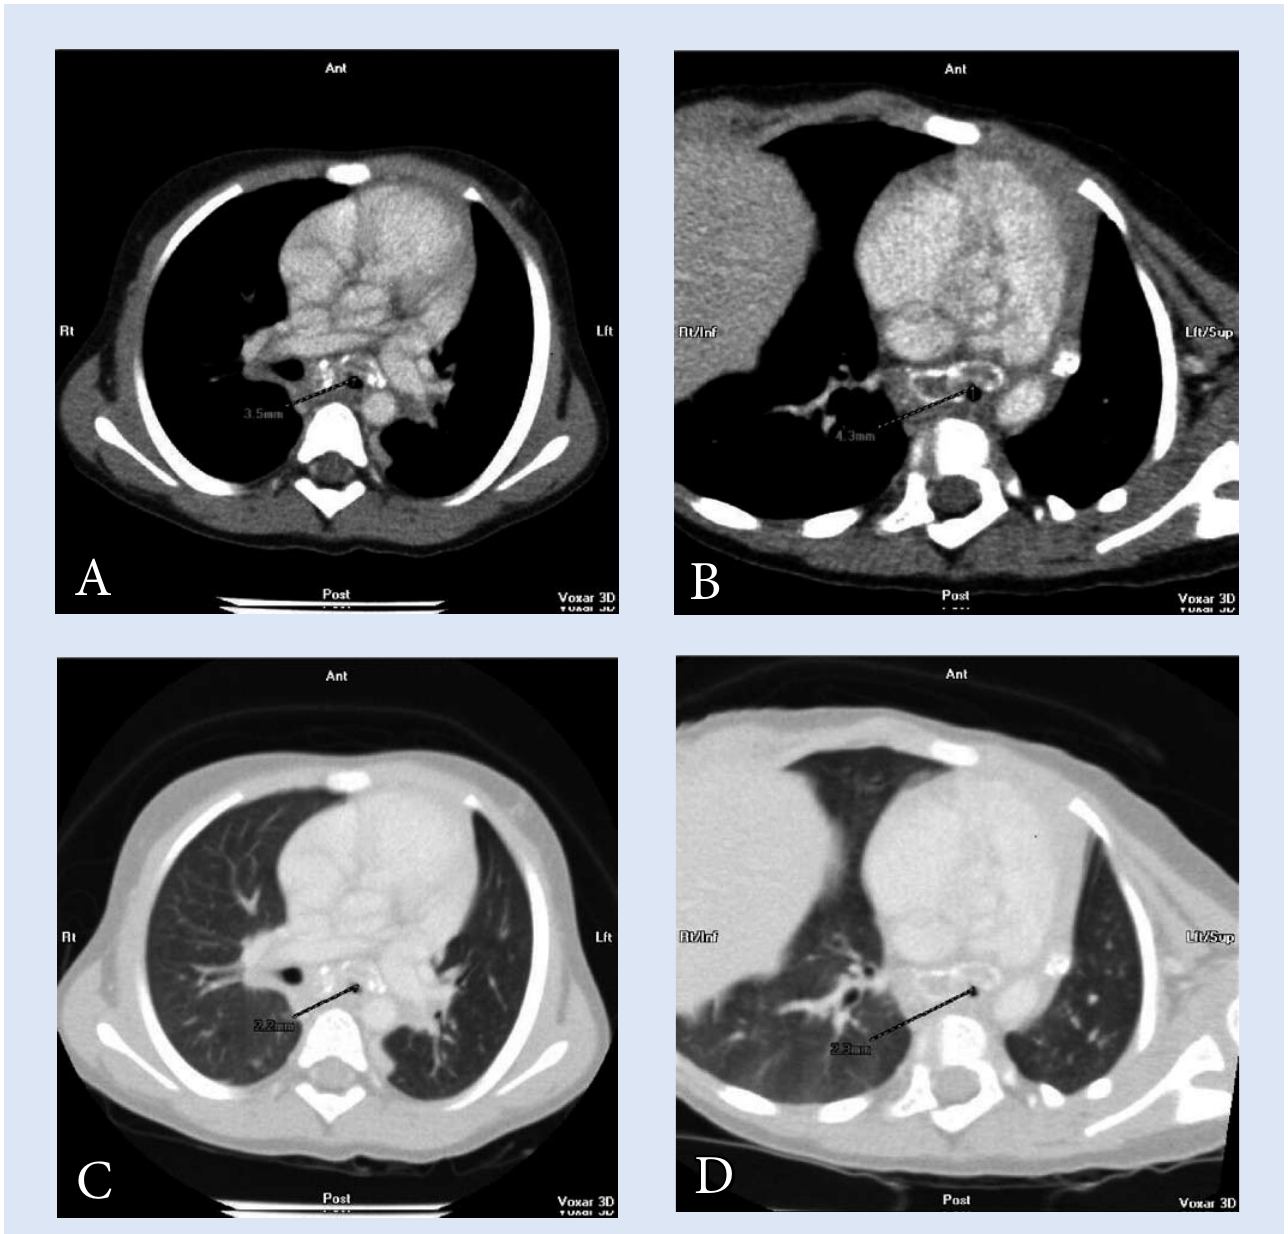
Fig. 1A - D. MDCT of the chest in a 25-month-old boy with compression of the left main bronchus owing to tuberculous lymphadenopathy. A: Standard axial image in soft tissue windows illustrating the measurement at the maximum stenosis in the left main bronchus (3.5 mm). B: Measurement of diameter after MPR along the longitudinal axis of the airway (4.3 mm). Note the calcified lymphadenopathy around the airway. C: Image A in lung windows, measurement 2.2 mm. D: Image B in lung windows, measurement 2.3